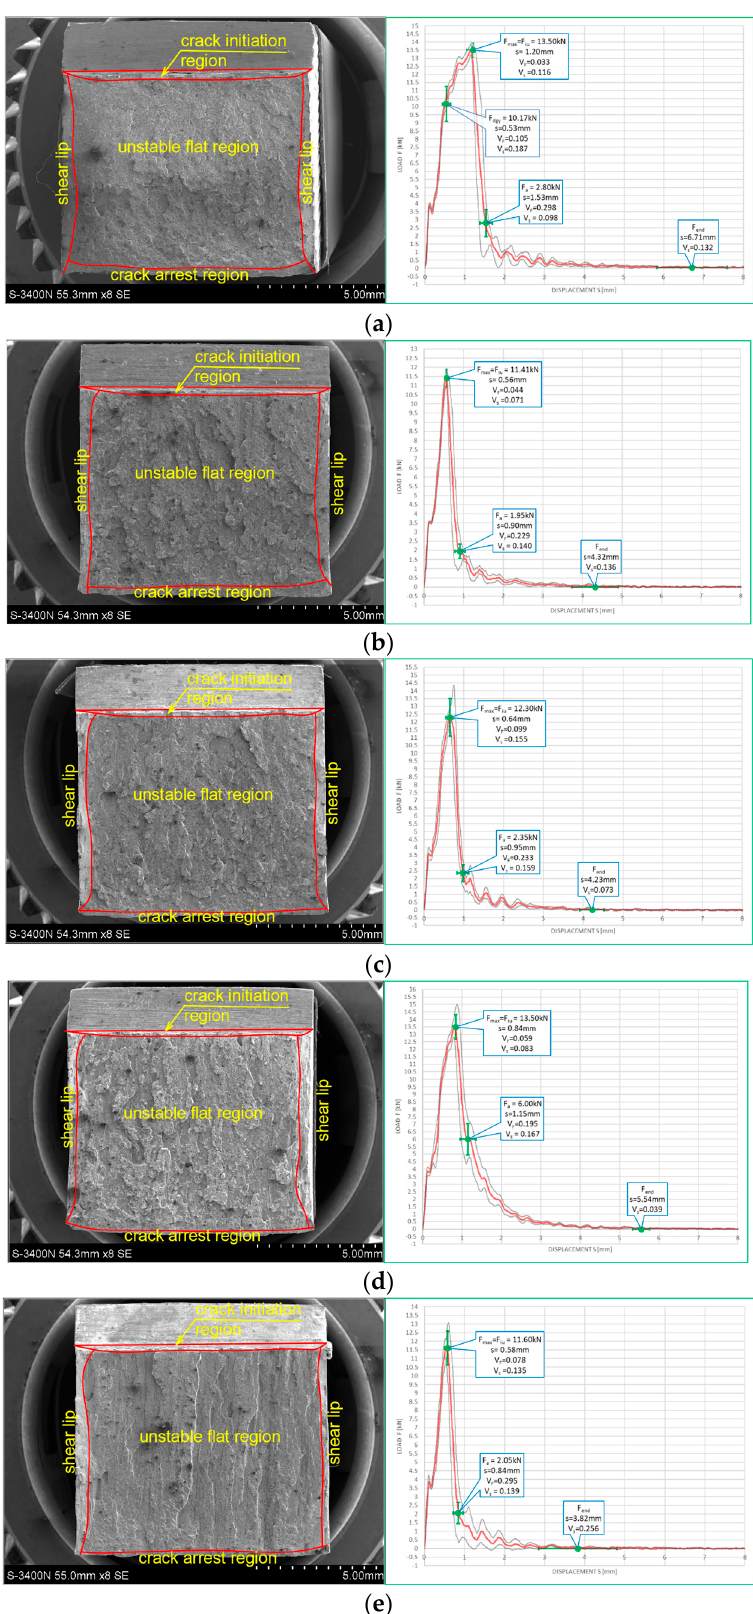
Figure 14. Morphology of the impact fractures obtained during the tests conducted at +20 °C on the samples made of X20Cr13 steel—denotations follow the key listed in Table 1. ( a ) 2 (+20) ; ( b ) 260 (+20) ; ( c ) 261 (+20) ; ( d ) 280 (+20) ; ( e ) 281 (+20) .